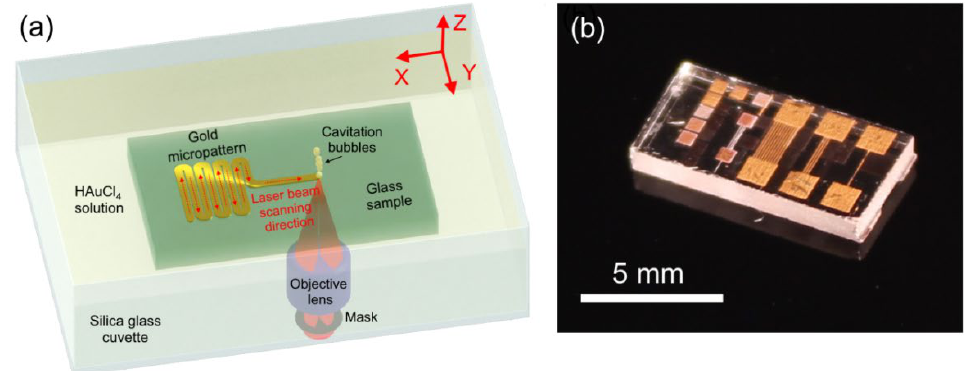
Figure 1. ( a ) Scheme of one-step laser-assisted gold micropatterning on glass substrate. ( b ) Photo- graph of glass sample with deposited gold micropatterns.